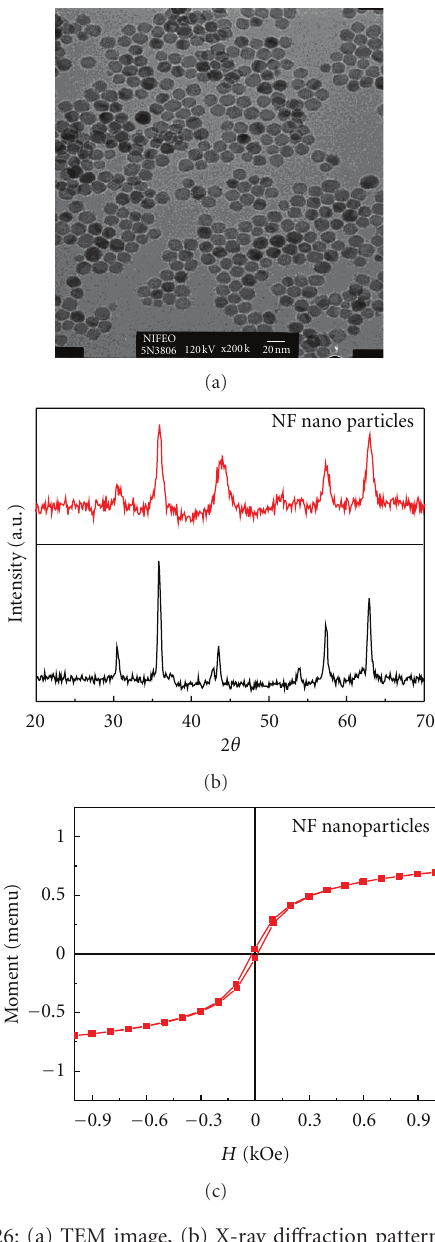
Figure 26: (a) TEM image, (b) X-ray di ff raction pattern, and (c) magnetic properties of NF nano